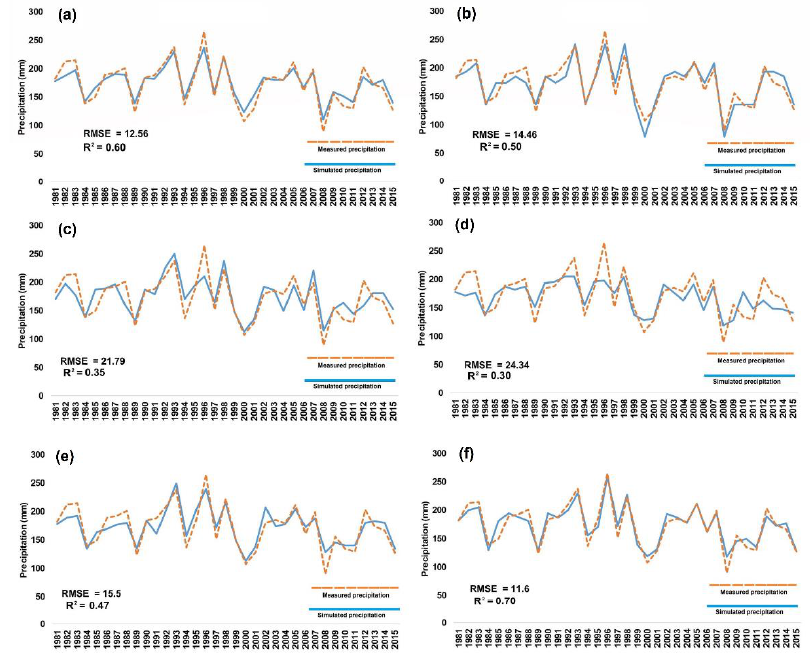
Figure 7. Time series of measured monthly precipitation amounts from the Climatic Research Unit (CRU3.23TS) dataset [23] compared to simulated precipitation amounts obtained from the various machine learning (ML) models including (a) Random Forest, (b) Decision Tree, (c) ANN, (d) DNN, (e) Gboost, and (f) XGboost during the wet period. RMSE and R 2 values indicate the accuracy of the developed ML models.